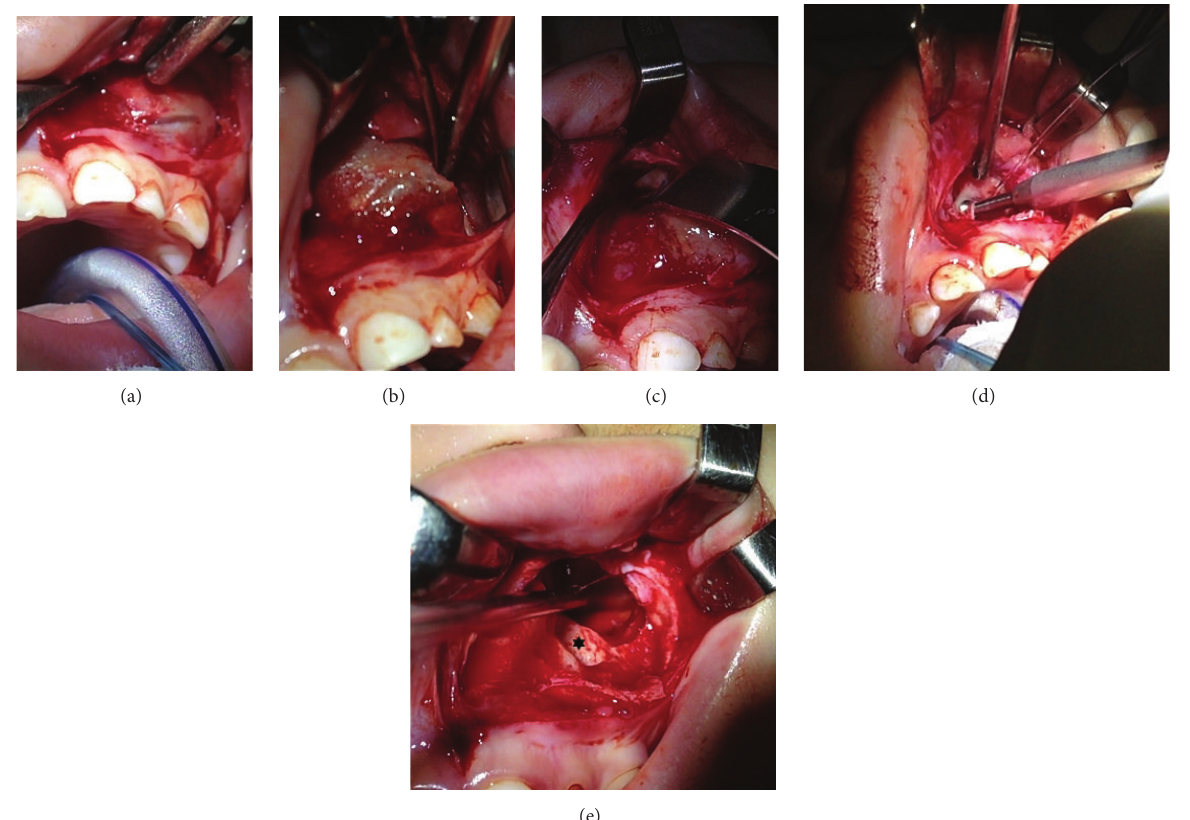
Figure 3: Surgery steps 2 to 5. *Dental germ